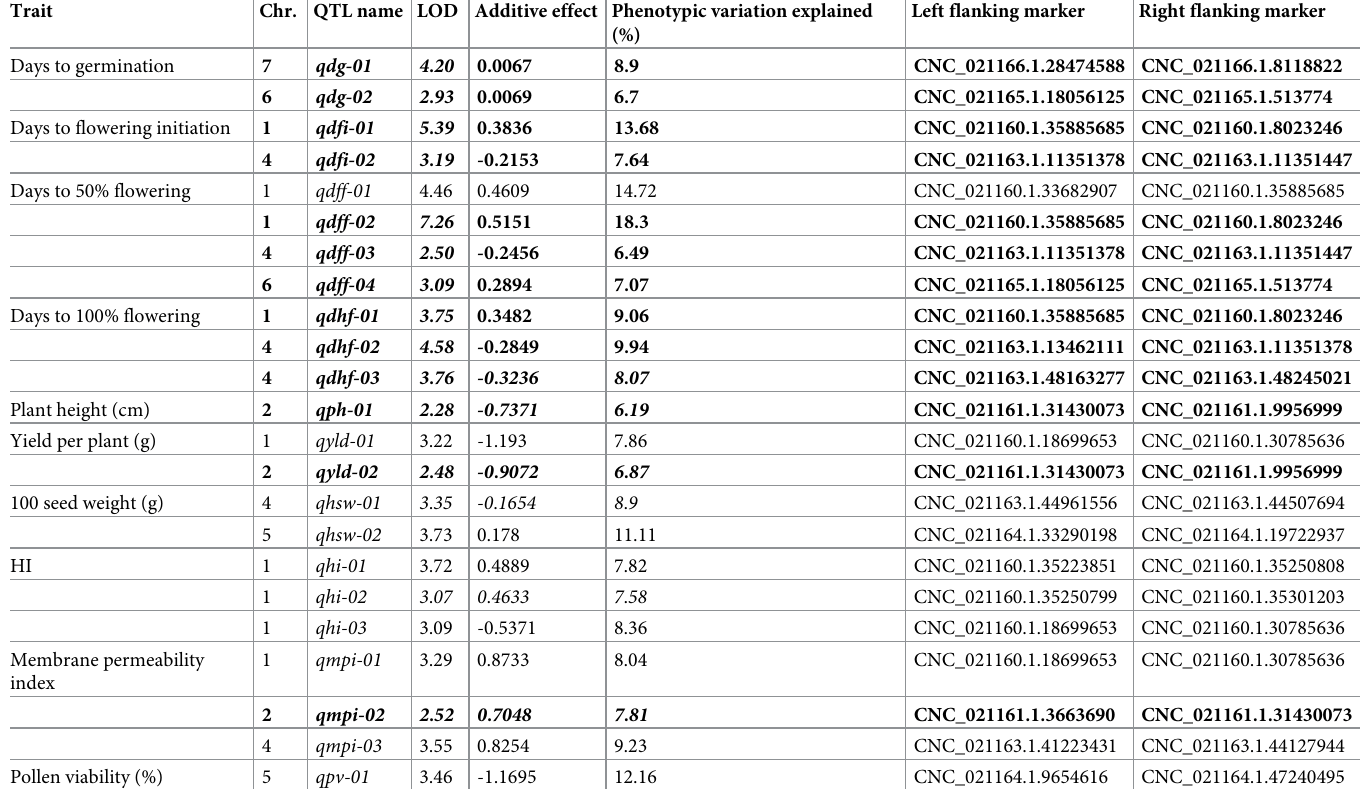
Table 3. Summary of the QTLs associated with the heat stress related traits at Faridkot.